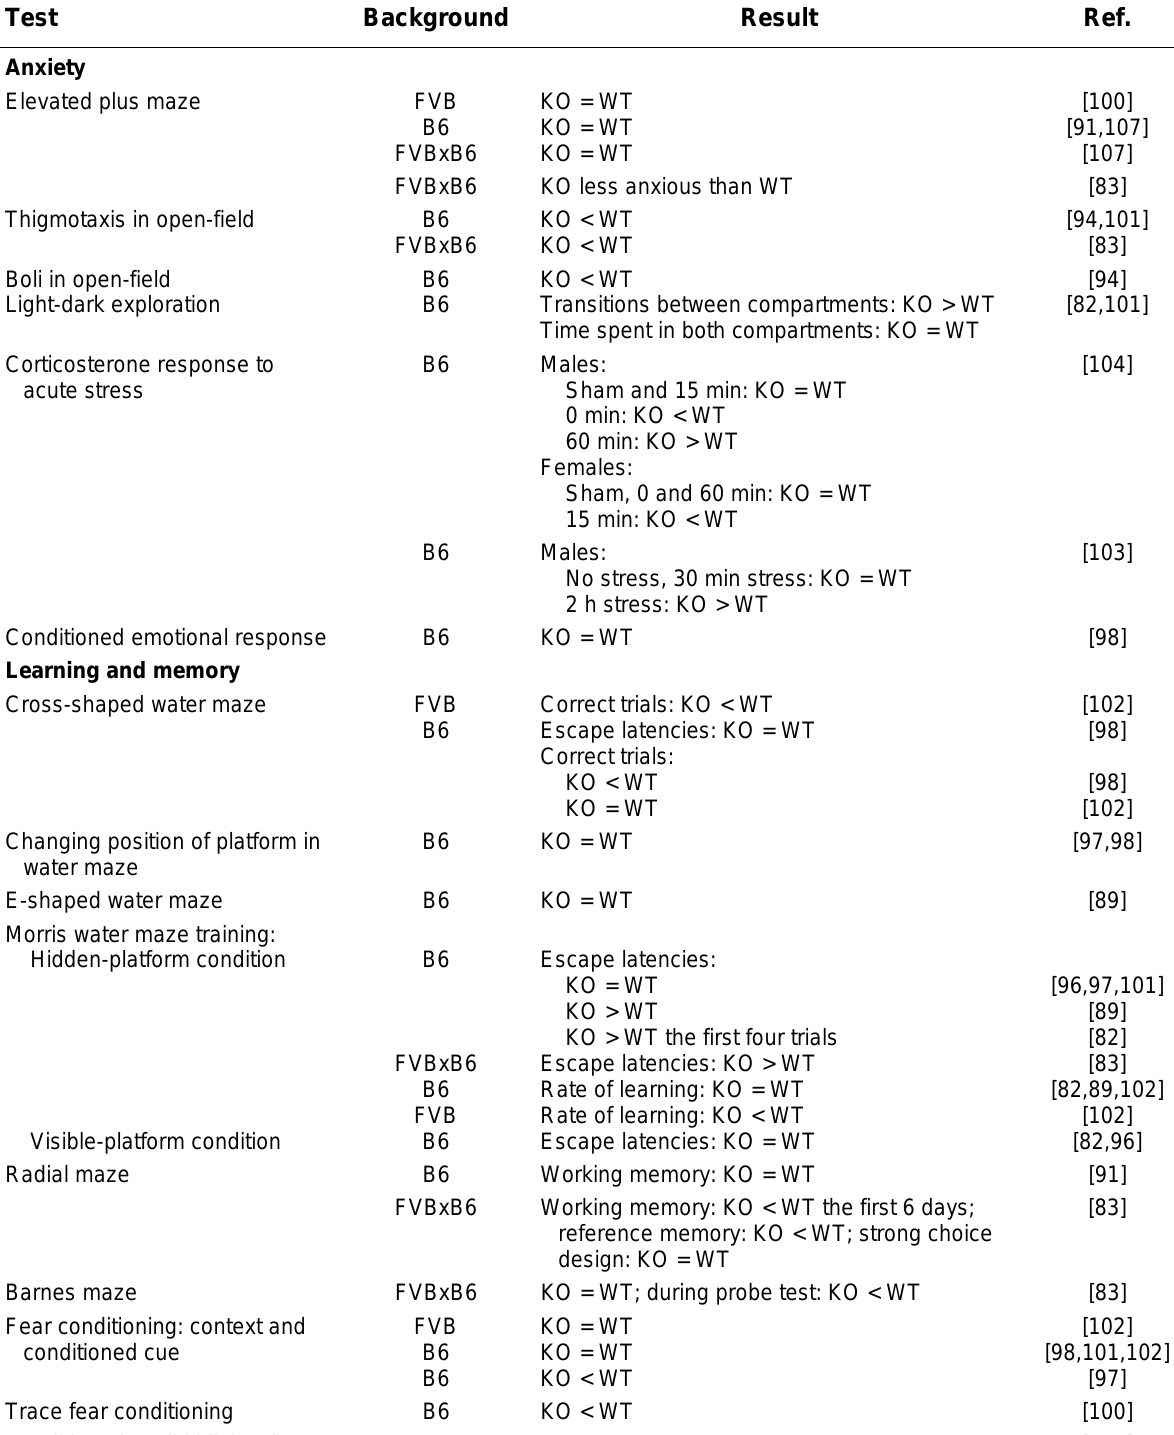
Phenotypical Checkup of Fmr1 KO Mice: Behaviors Relevant to Variable Symptoms of Autism Test